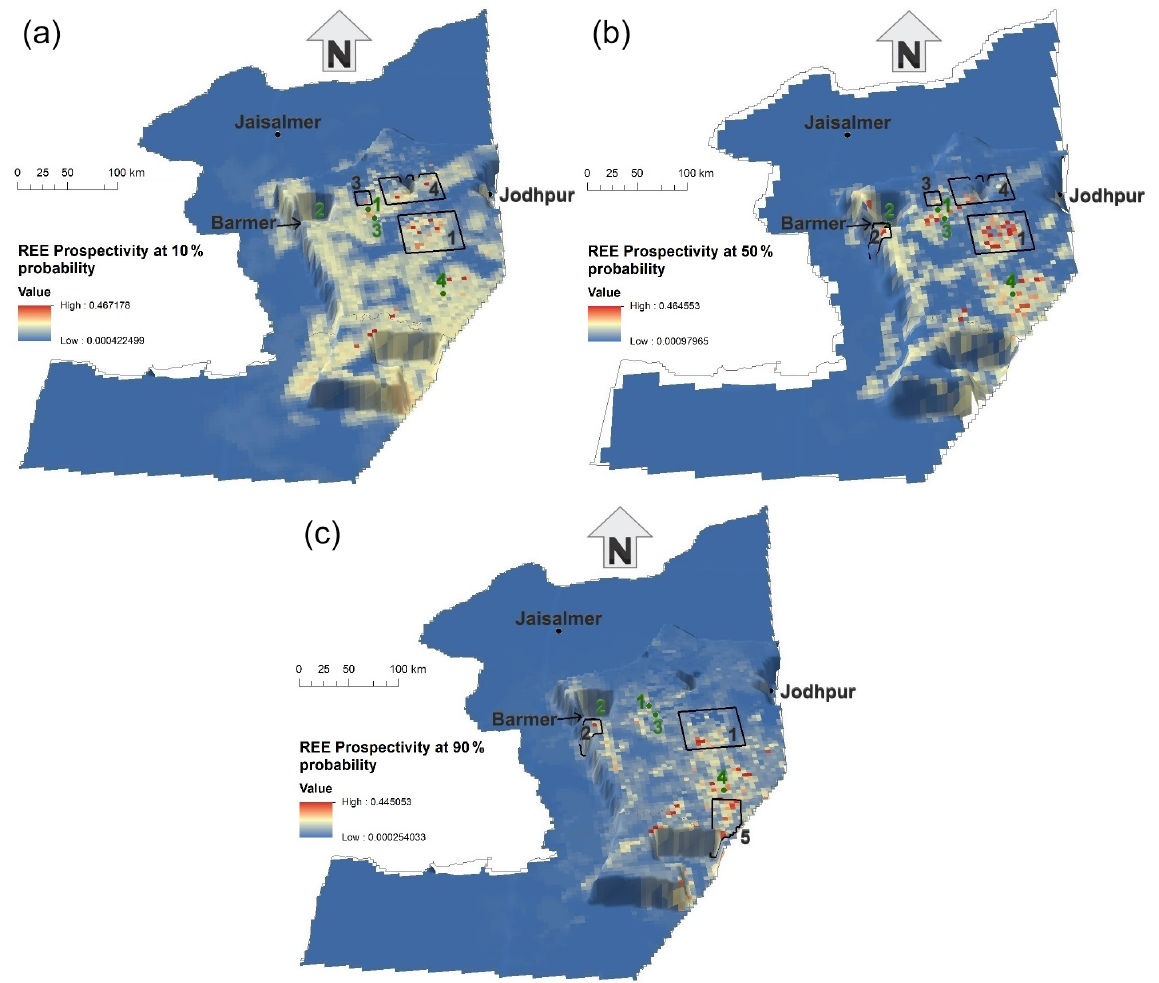
Figure 5. Continuous-scale prospectivity maps at 10%, 50% and 90% probability levels draped over the confidence layer, shown in (a) , (b) and (c) , respectively. The colours mark increasing prospectivity from low (blue) to high (red). The elevations mark high confidence in the data used for prospectivity modelling. Black balls indicate major cities, and green balls indicate known carbonatite occurrences; green numbers correspond to the known carbonatite occurrences: 1 – Sarnu-Dandeli, 2 – Danta-Langera-Mahabar, 3 – Kamthai, 4 – Mundwara. Areas marked with black numbered rectangles are discussed in Sect.